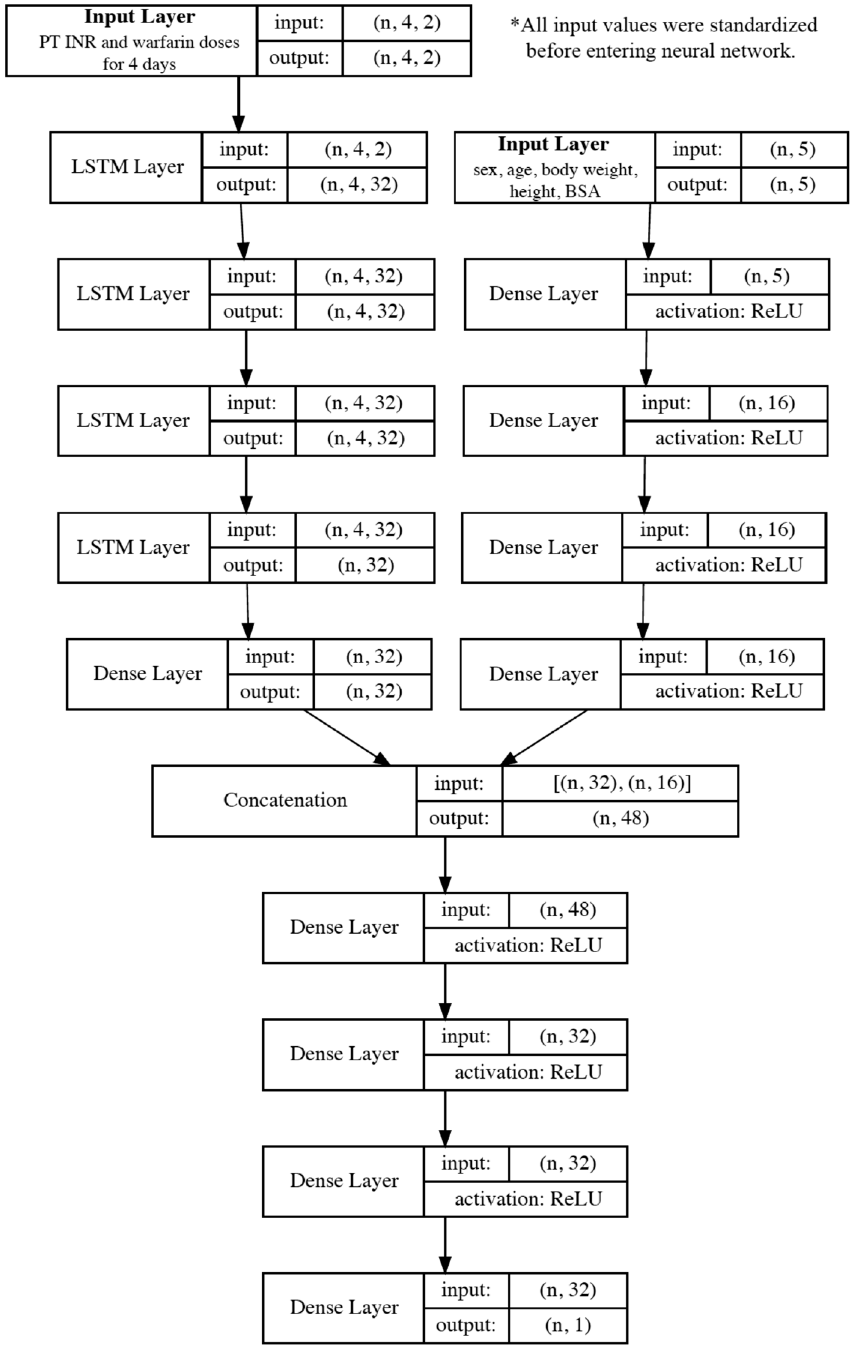
Figure 4. Structure of the 5th-day prothrombin time international normalized ratio (PT INR) prediction model. Five basic variables enter the dense neural network layers and time-series variables (PT INRs and warfarin doses) enter the long-short term memory (LSTM) layers. The parameters from both networks are concatenated and pass through dense neural network layers. Finally, the network produces a single prediction for the 5th-day PT INR. BSA body surface area, WFR